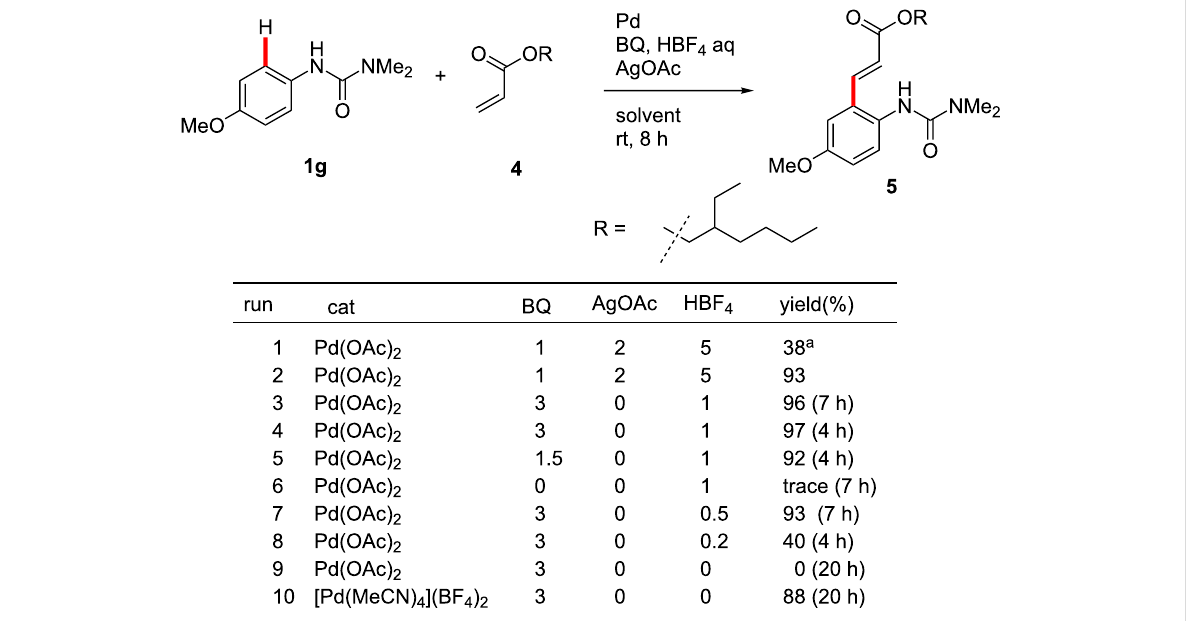
Figure 5: Optimization. Conducted at rt for 8 h or as otherwise noted in EtOAc with 10 mol % Pd catalyst, AgOAc, HBF 4 , arylurea ( 1g , 0.25 mmol), BQ and acrylate ( 2c , 2.0 equiv). a 2 wt % Brij 35 in water instead of EtOAc.